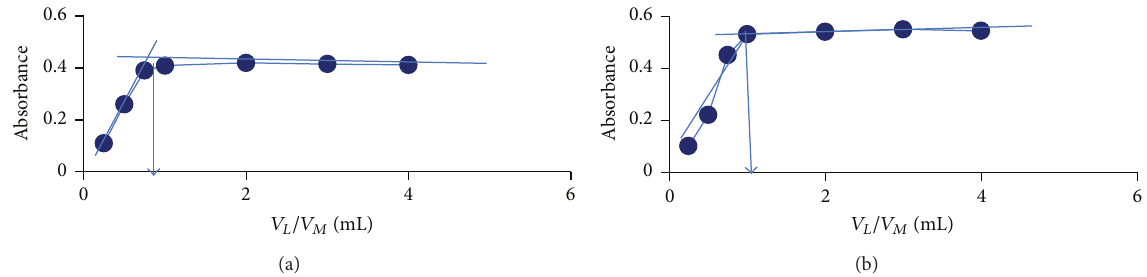
Figure 5: The mole ratio curves for the formation of (a) TC-Au(III) and (b) TC-Hg(II) complexes in solutions at optimum conditions.